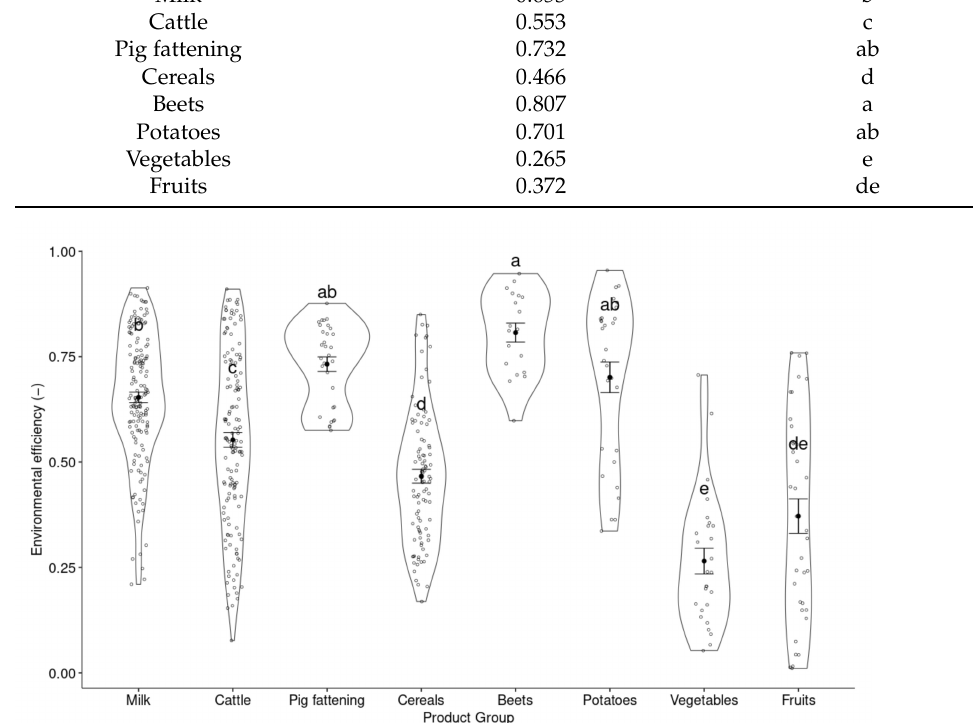
Figure A10. ANOVA Product Groups vs. environmental efficiency. The grey dots mark observations. Black dots mark mean value, error bars mark standard error. Different letters indicate a difference of means is significant at the 5%